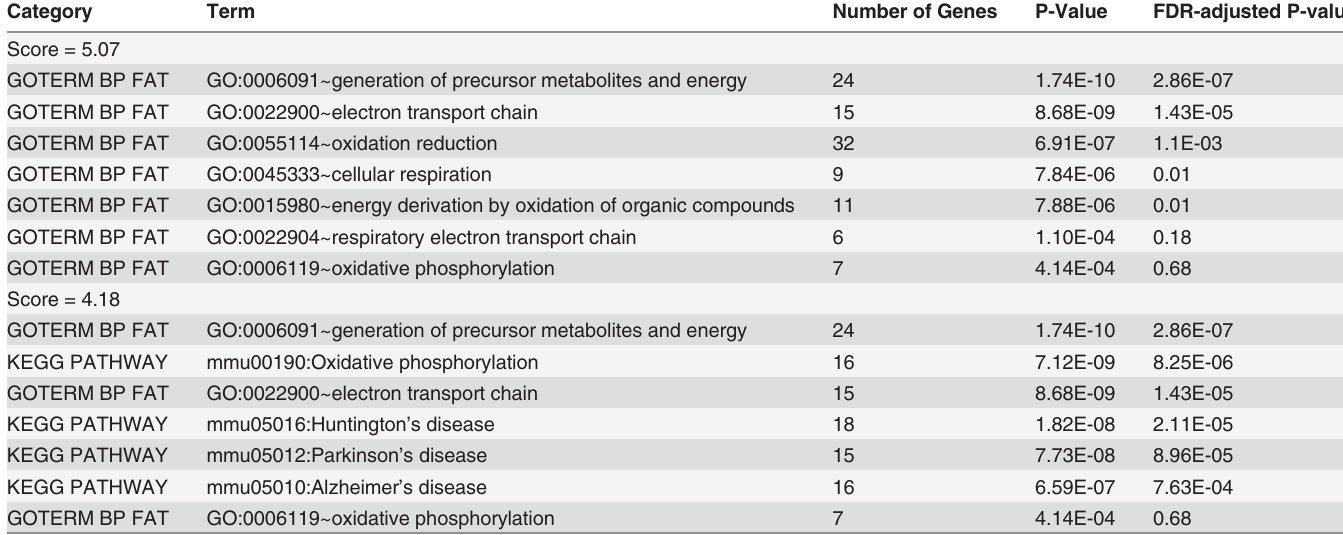
Table 5. Enriched (enrichment score > 3.0) clusters of Gene Ontology (GO) biological process (BP), molecular function (MF) Functional Annotation Tool (FAT) categories, and KEGG pathways among the genes under- or over-expressed in the active wild-type vs inactive myostatin-reduced contrast and not differentially expressed in all other contrasts.